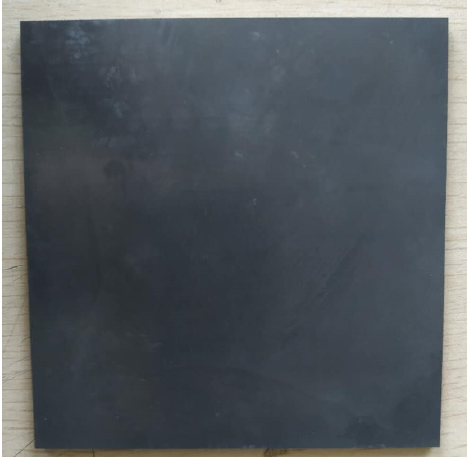
Figure 1. The image of the 120 × 120 × 5.5 mm laminated ceramic prepared in this study (gradual layered). (gradual